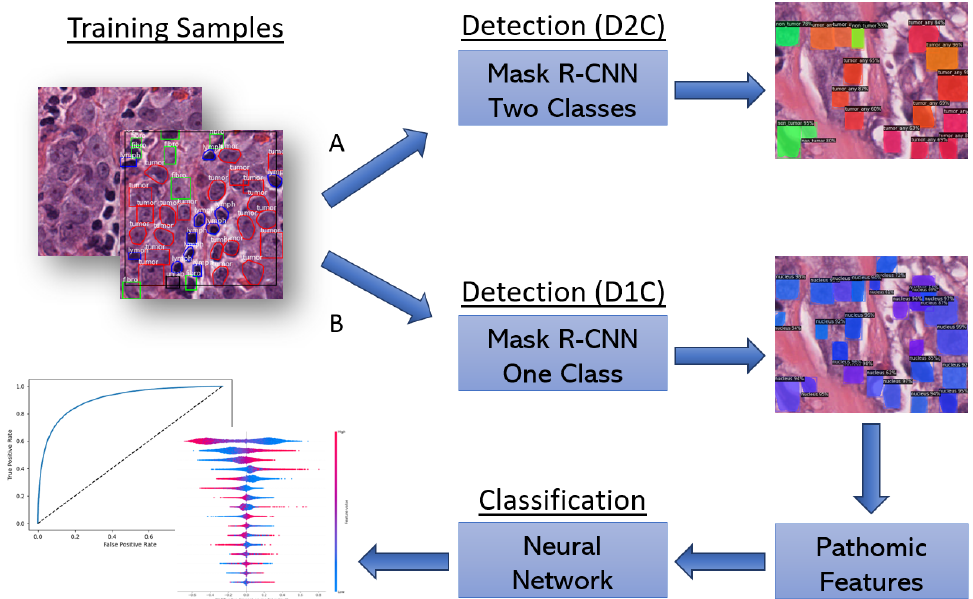
Figure 2. Study workflow ( A : end-to-end approach, B : two-stage approach). The end-to-end approach exploits the Mask R-CNN method with two classes to perform both the detection and classification of tumor and non-tumor nuclei. The two-stage approach, on the other hand, permits us to focus on pathomic features that can be used to gain an understanding of which textural and morphological characteristics are more relevant for recognizing tumor nuclei.